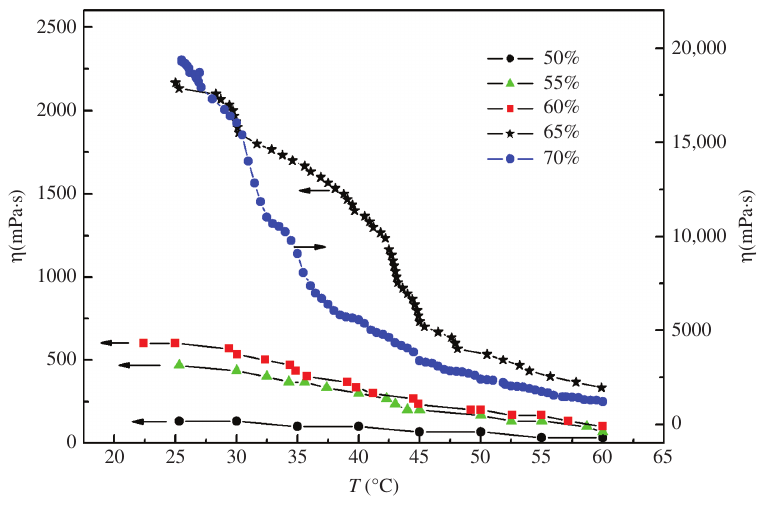
Figure 7 Relationship between impregnation solution viscosity and temperature at different concentrations.